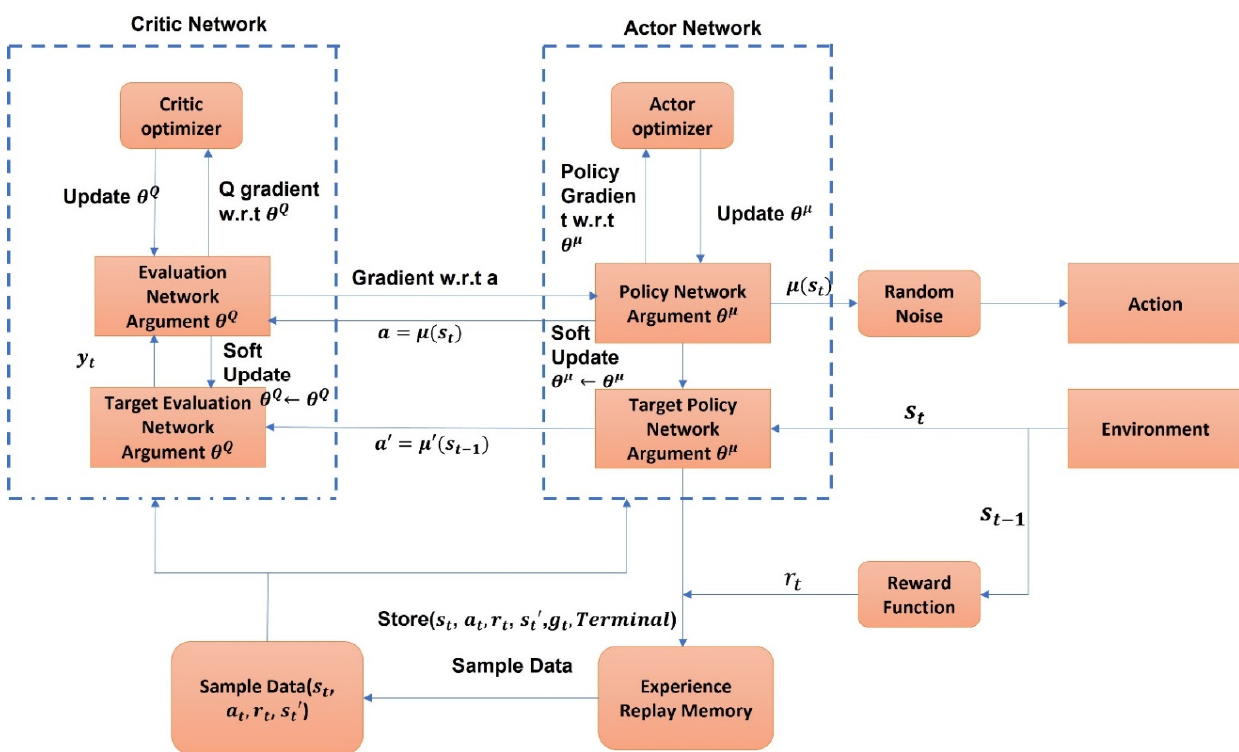
Figure 6. With Modified ERM. The ERM is used to adjust the critical feedback for correct assessment.